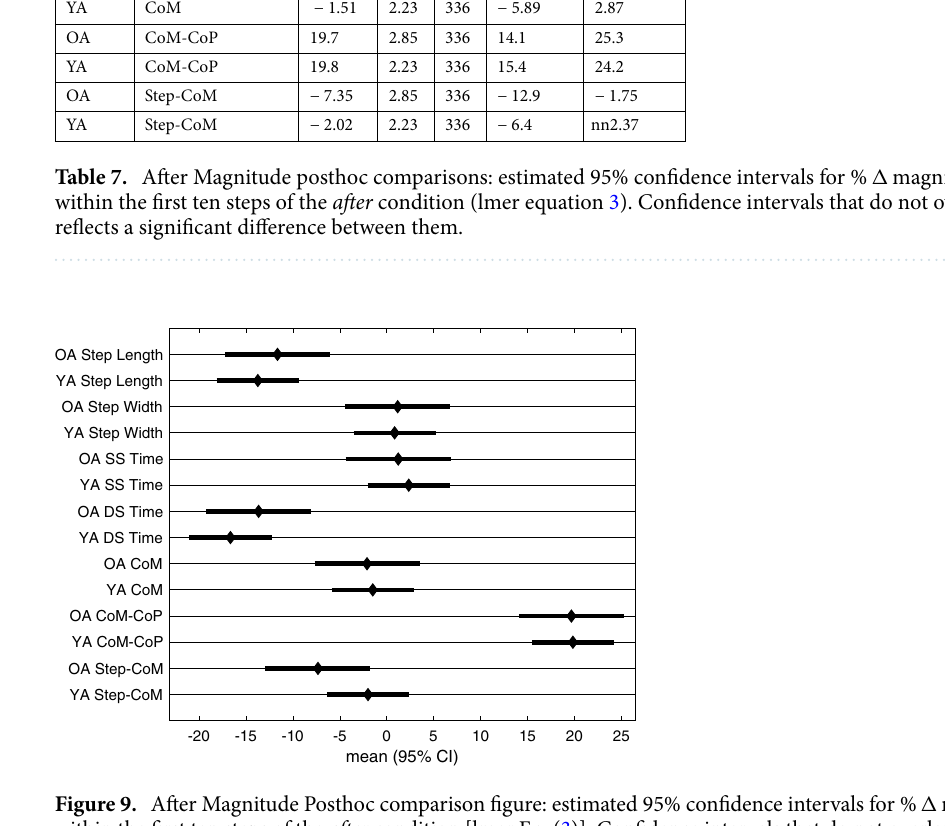
Figure 9. After Magnitude Posthoc comparison figure: estimated 95% confidence intervals for % (cid:31) magnitude within the first ten steps of the after condition [lmer Eq. (3)]. Confidence intervals that do not overlap reflects a significant difference between